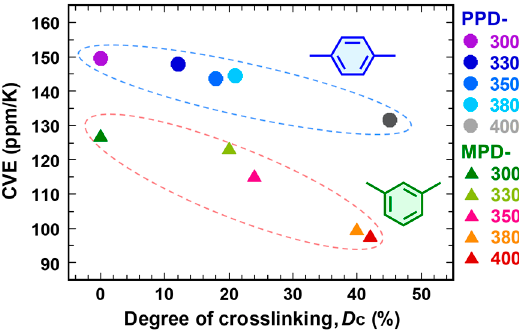
Figure 9. Plots of the CVE values as a function of the degree of crosslinking ( D C ) for the PI films.